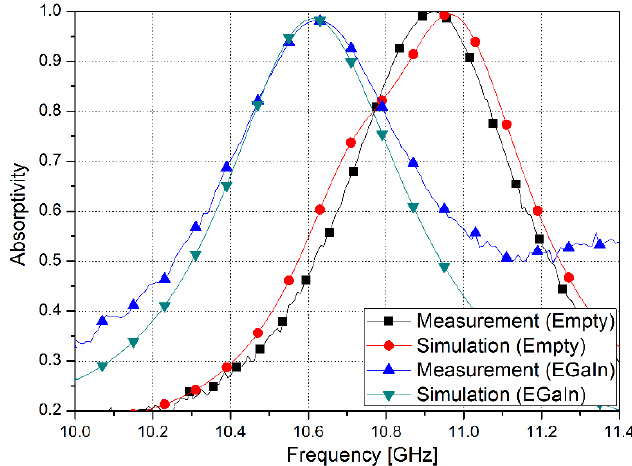
Figure 8. Simulated and measured results for proposed metamaterial absorber